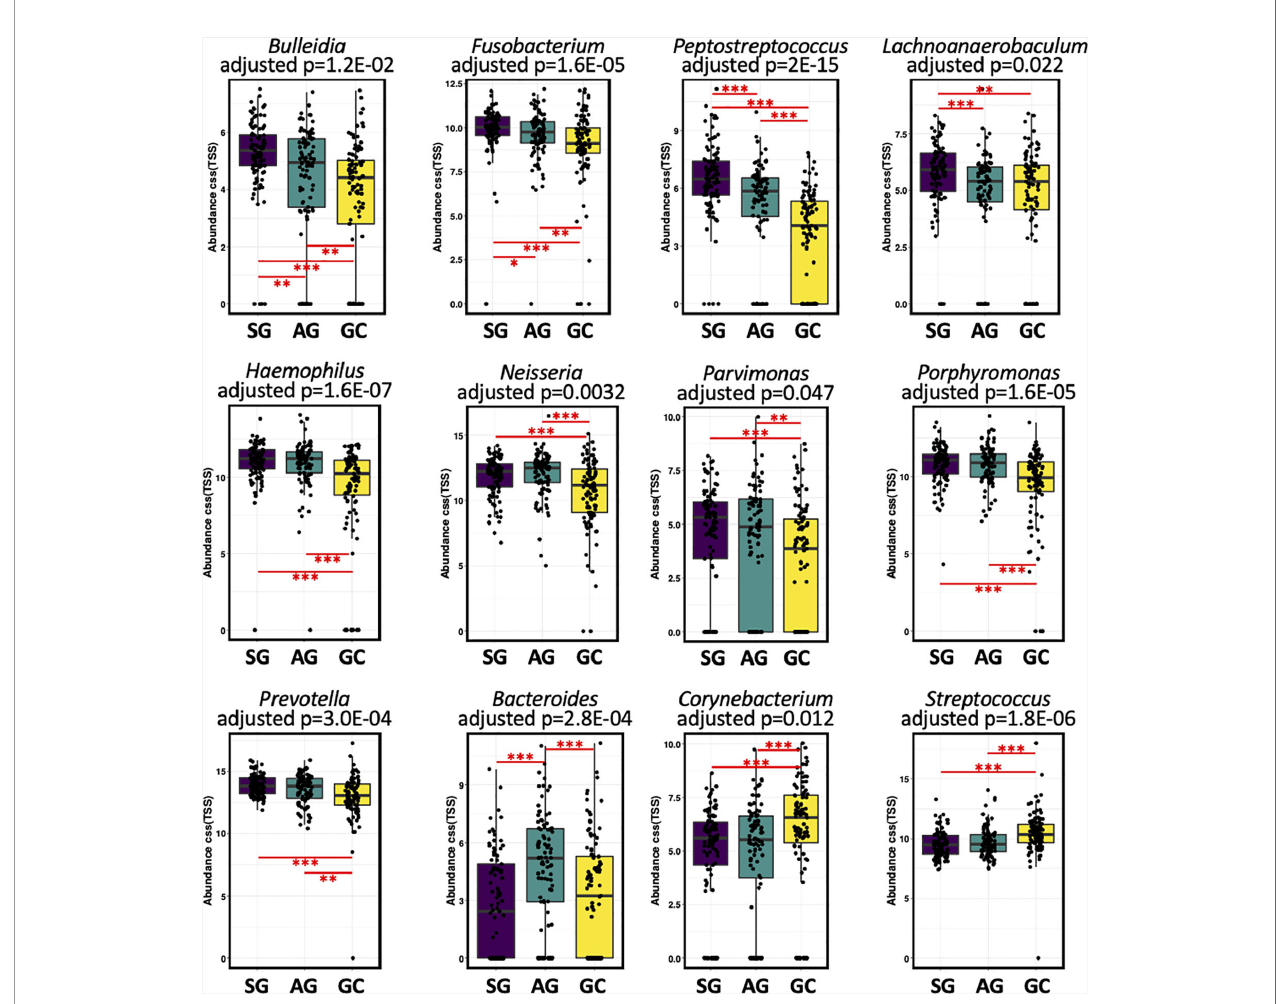
FIGURE 2 | The salivary microbiota composition in patients with malignant and non-malignant gastric lesions. Relative abundance of salivary taxa of the three groups were compared at the genus level. Signi fi cance was determined by using Kruskal-Wallis rank sum test with BH-adjusted P < 0.001, and Wilcoxon rank-sum tests for each of the two groups with *BH-adjusted P < 0.05, **BH- adjusted P < 0.01, and ***BH-adjusted P <